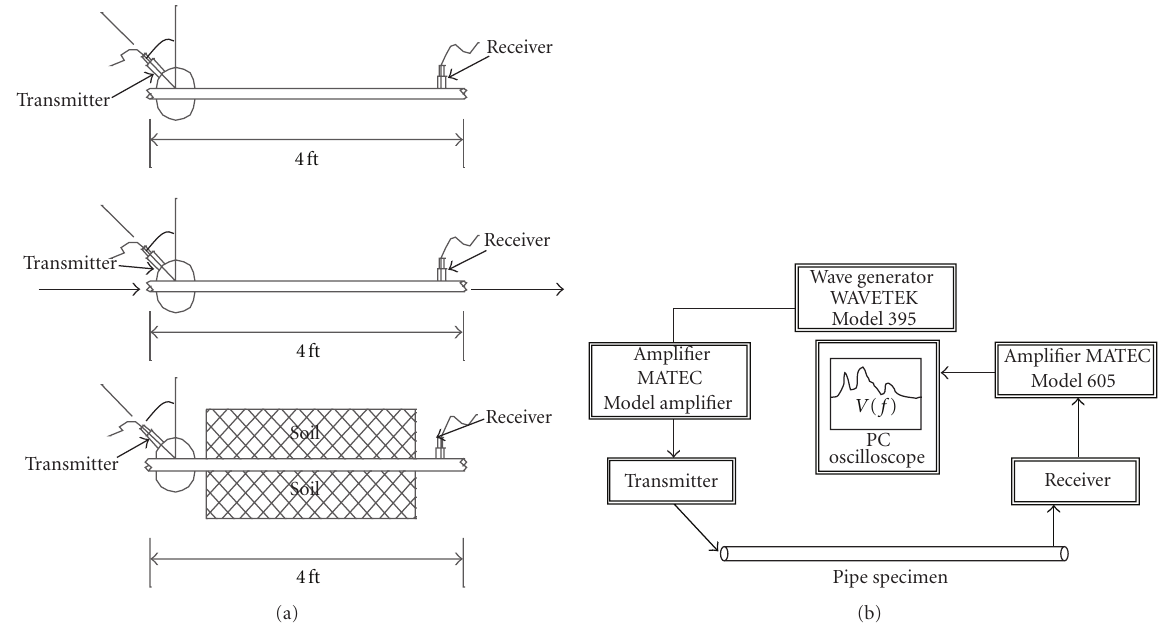
Figure 1: (a) experimental setup (i) pipe in traction-free boundary condition, (ii) when water flows through the pipes, and (iii) pipes embedded in soil. (b) schematic diagram of the instrumental arrangement.